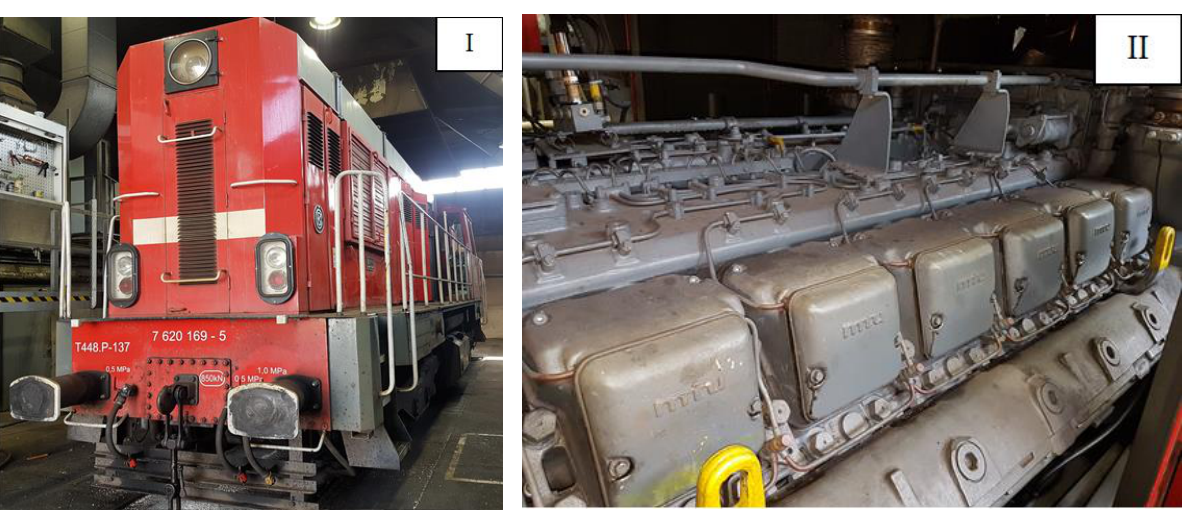
Fig. 7. General view: I – diesel locomotive T448, II – diesel engine